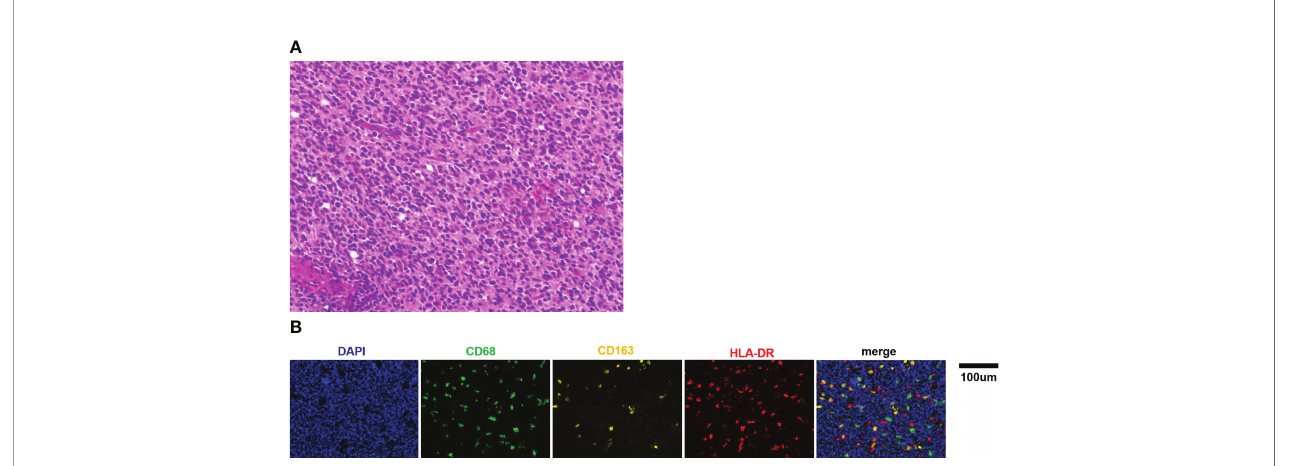
FIGURE 1 | (A) Representative picture of H&E staining for medulloblastoma (×400). (B) Representative immuno fl uorescence images of CD68, CD163, and HLA-DR staining in medulloblastoma tissue sections. Scale bar, 100 m